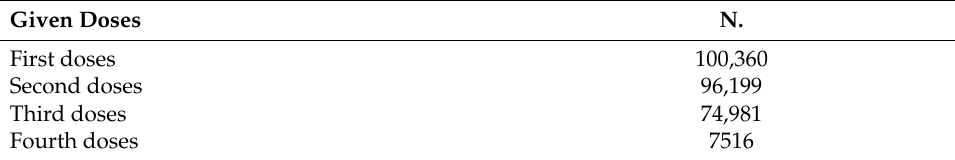
Table 2. Details of the number of doses administered per